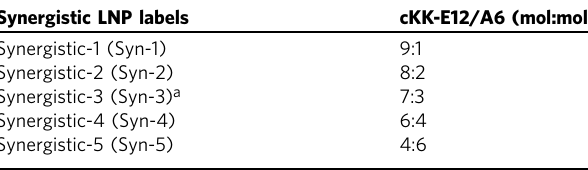
Table 1 Labels for LNPs containing two amine